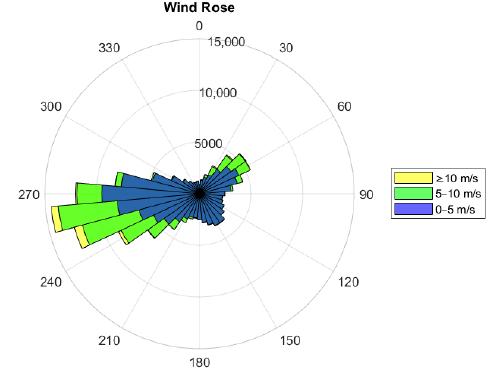
Table 3. Descriptive statistics of the whole dataset.